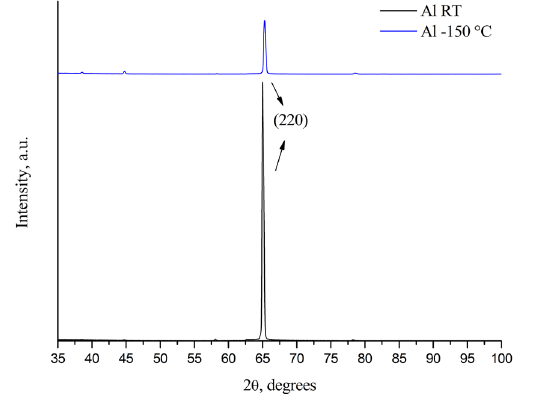
Figure 6. XRD aluminum rolled at RT and CT.